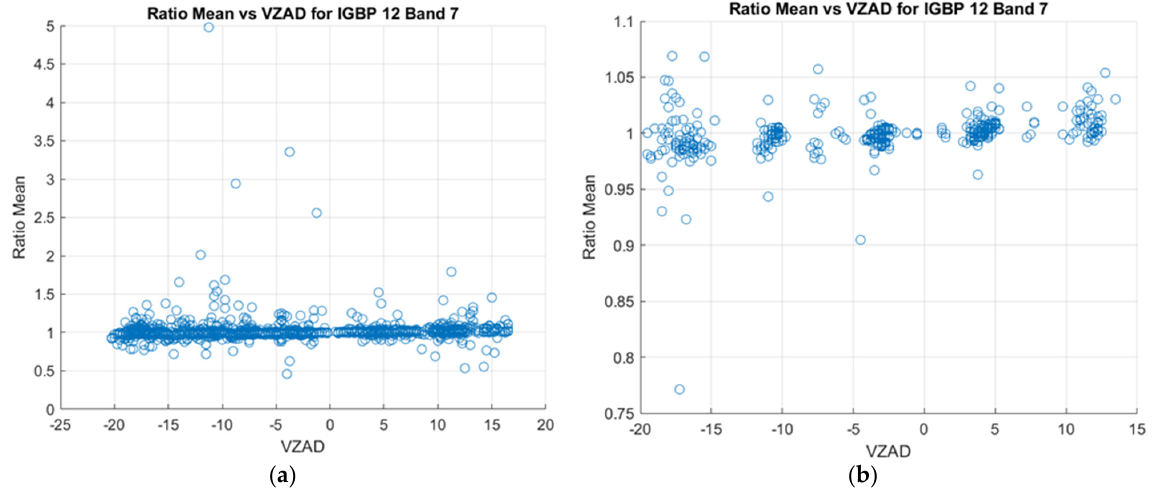
Figure 12. ( a ) Unfiltered ratio mean vs. VZAD. ( b ) Filtered ratio mean vs. VZAD.